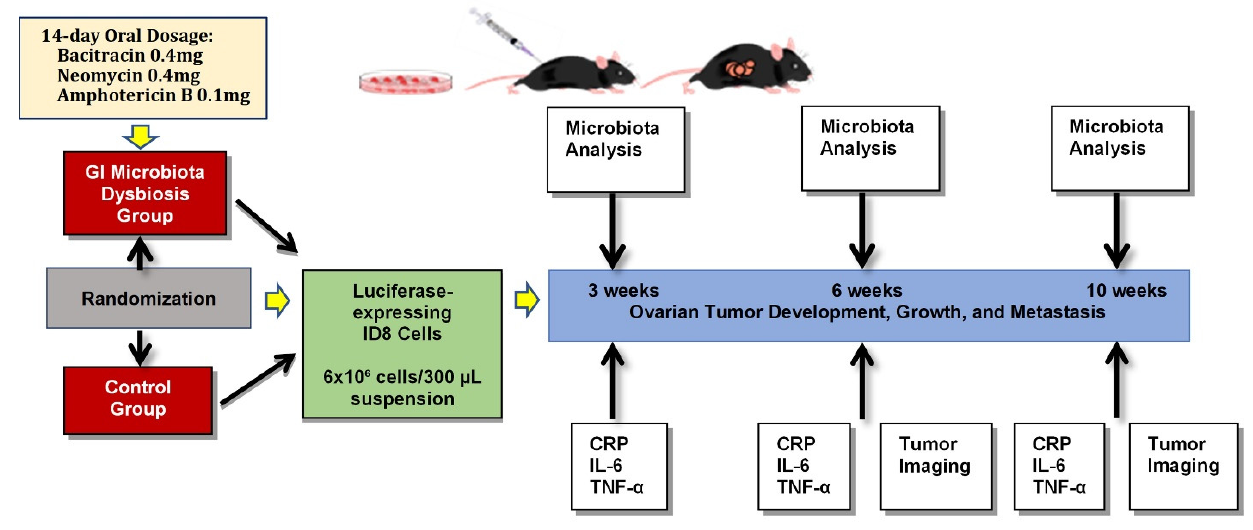
Figure 1. Experimental design.